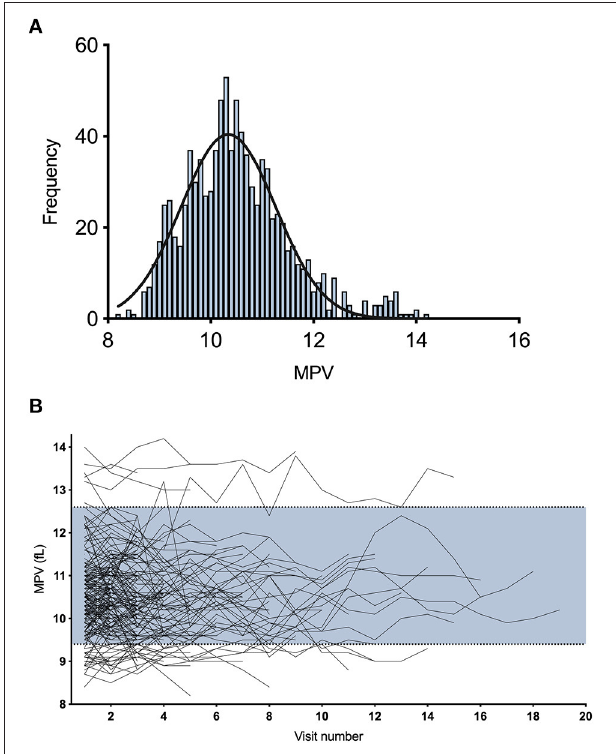
FIGURE 1 | Distribution of mean platelet volume in SLE measured longitudinally. (A) Frequency distribution of all 212 study patients collected during 944 visits with a fitted normal curve. (B) Individual variations in MPV over time. The blue area represents the normal range (9.4–12.6